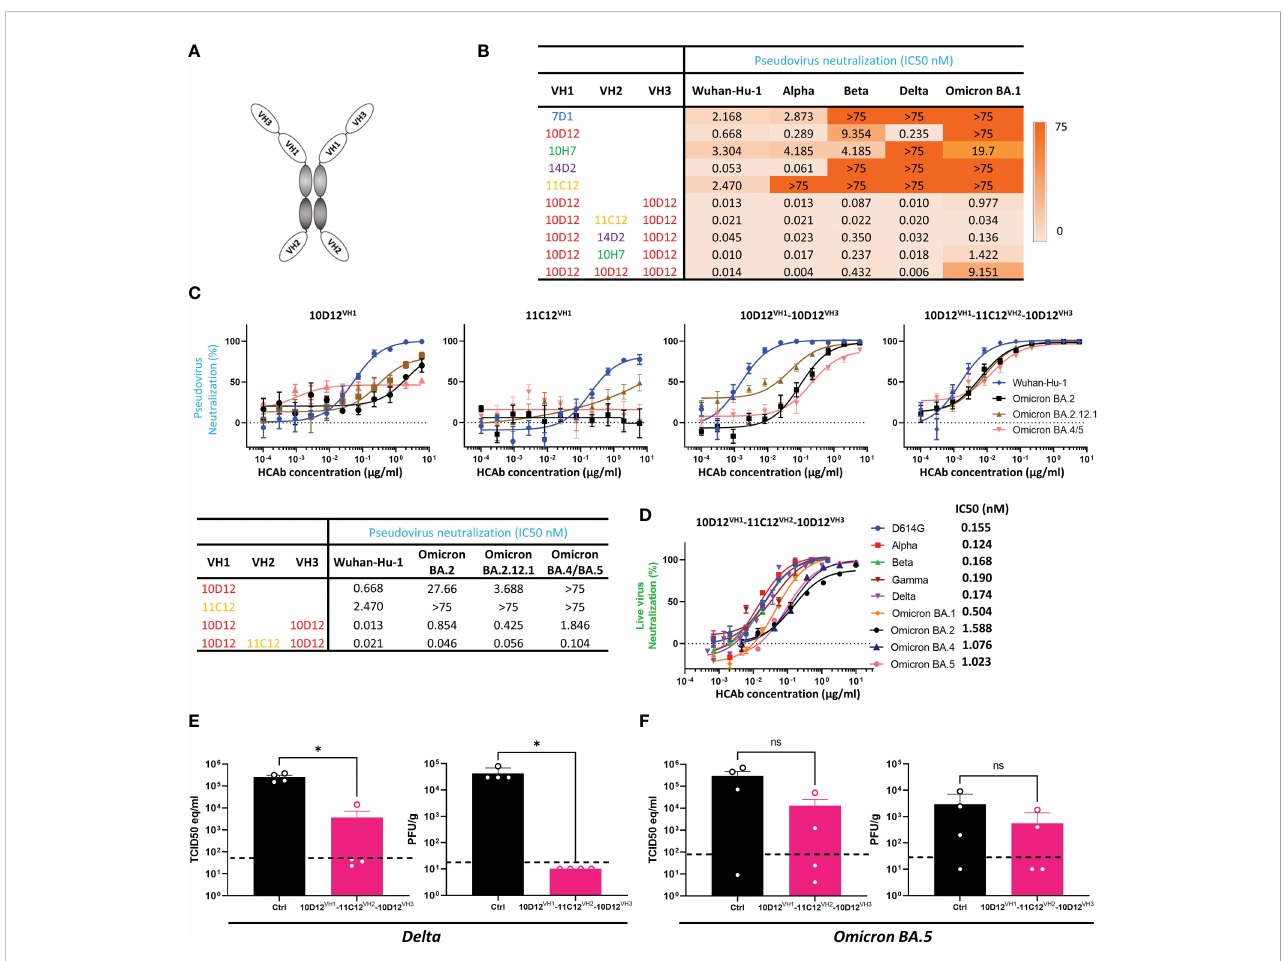
FIGURE 3 Neutralization breadth of bi-, tetra- and hexavalent HCAbs and protective activity of a hexavalent, biparatopic HCAb against Delta and Omicron BA.5 in hamsters. (A) Schematic depiction of hexavalent HCAb which combines three different antigen binding domains. (B) IC50 values of bi-, tetra- or hexavalent HCAbs against virus particles pseudotyped with S proteins of ancestral SARS-CoV-2 (Wuhan-Hu-1) and variants including Alpha, Beta, Delta and Omicron BA.1. (C) Bi-, tetra- and hexavalent HCAbs mediated-neutralization of viruses pseudotyped with S proteins of ancestral SARS-CoV-2 and Omicron subvariants, with calculated IC50 values displayed in the table below. (D) Neutralization of D614G SARS-CoV-2 and variants by 10D12 VH1 - 11C12 VH2 -10D12 VH3 HCAb. Error bars indicate SD between two independent replicates. The prophylactic ef fi cacy of 10D12 VH1 -11C12 VH2 -10D12 VH3 (10 mg/kg) was tested in hamsters challenged with SARS-CoV-2 Delta (E) or Omicron BA.5 (F) in comparison to non-treated (control) hamsters. Viral RNA loads (left panels) and infectious virus titers (right panels) are shown. Mann-Whitney U test was used to evaluate the statistical difference between the antibody and mock-treated groups (*, p < 0.05; ns, p >